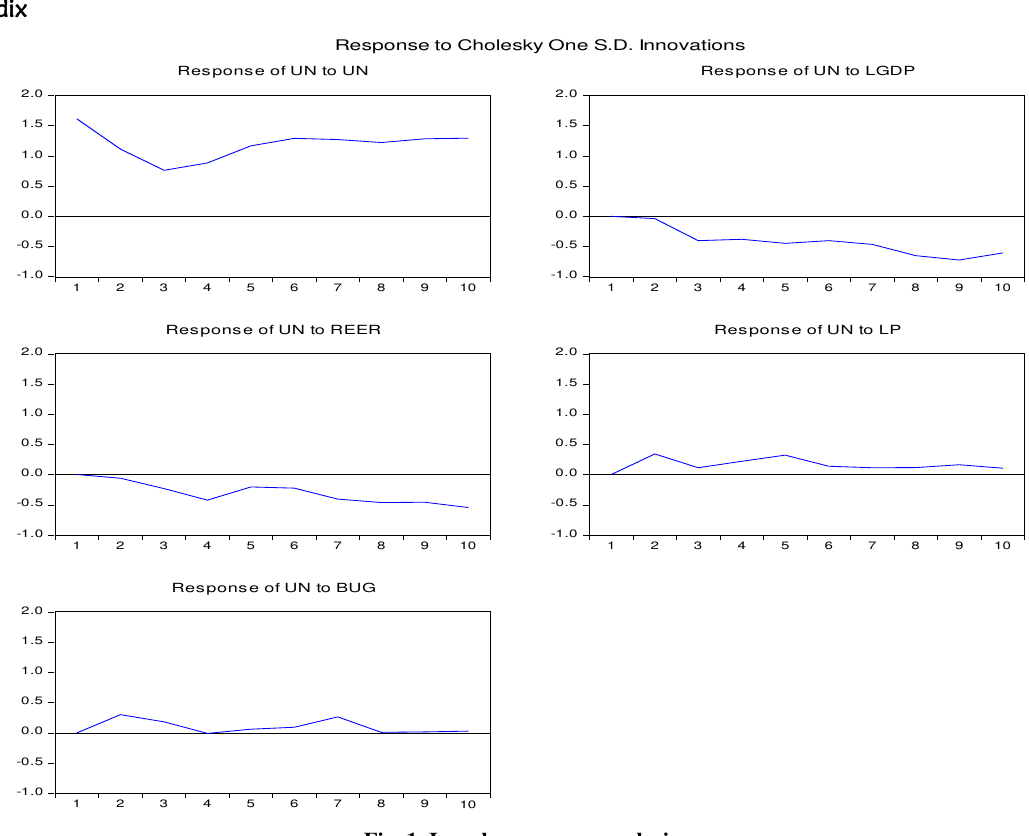
Fig. 1. Impulse response